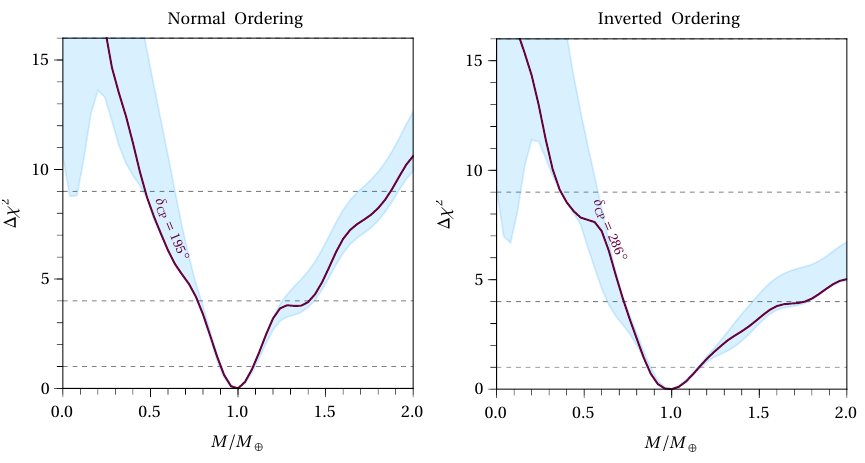
Figure 13 . DUNE’s 400 kton-year sensitivity to the total mass of the Earth (assuming the shape of the matter density profile is known) for the current global best fit value of δ (left panel) and inverted (right panel) neutrino mass ordering. The band encodes the sensitivity varying the true value of δ within 0 to 2 π CP